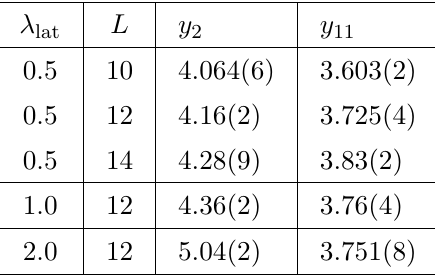
(cid:10) (cid:11) (cid:10) (cid:11) λ 2 and λ 2 2 11